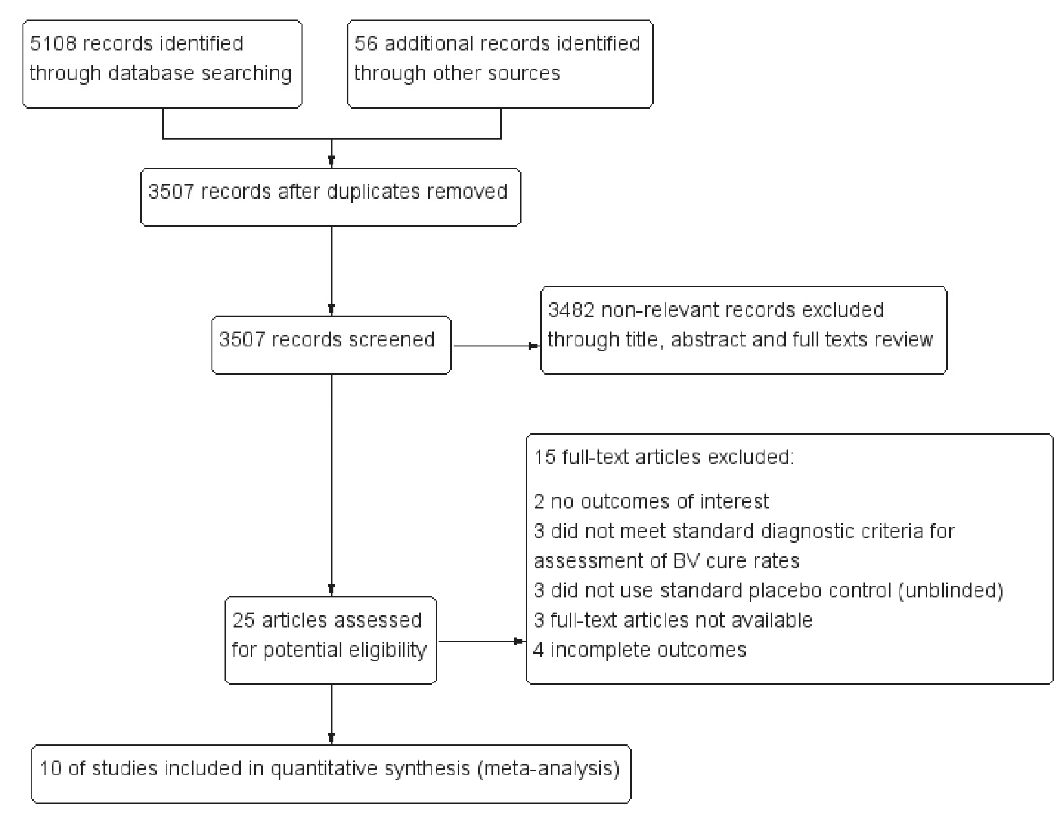
Figure 1. Study flow diagram. Abbreviations: RCTs = randomized controlled trials; BV = bacterial vaginosis.